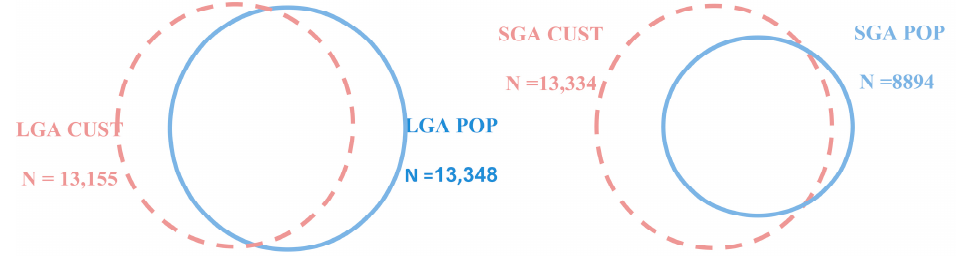
Figure 2. Birth weight by parity for the entire study cohort (mean birth weight).